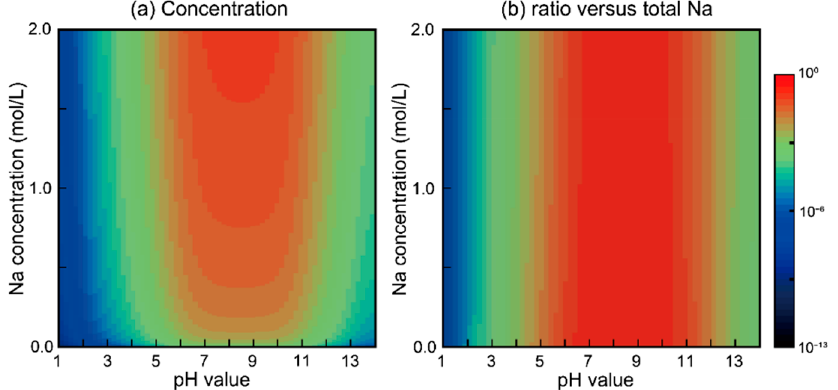
Figure 3. Calculated concentrations ( a ) and ratios ( b ) versus the total Na of NaHPO 4 − in a solution containing 1 mol/L PO 4 at 60 °C.